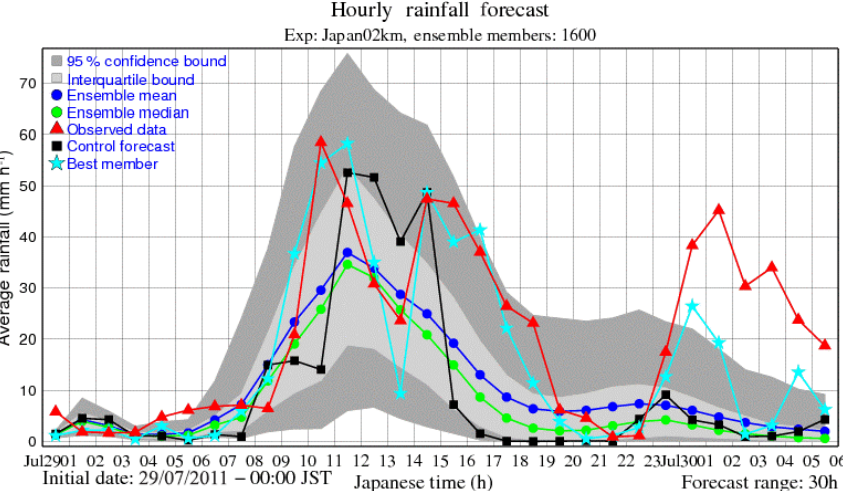
Figure 4. Time series of 1h accumulated rainfall over the catchment as forecasted by all ensemble members. The observation, control forecast, ensemble mean forecast and best member forecast are also plotted for comparison. Here, the best member is defined as the member that has the minimum distance between its time series and the observed time